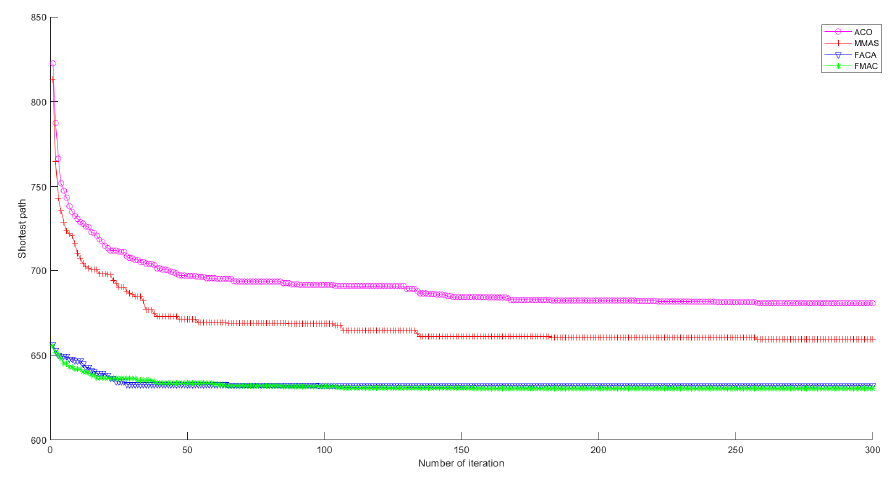
Figure 10. Average shortest path curve after each iteration in eil101.